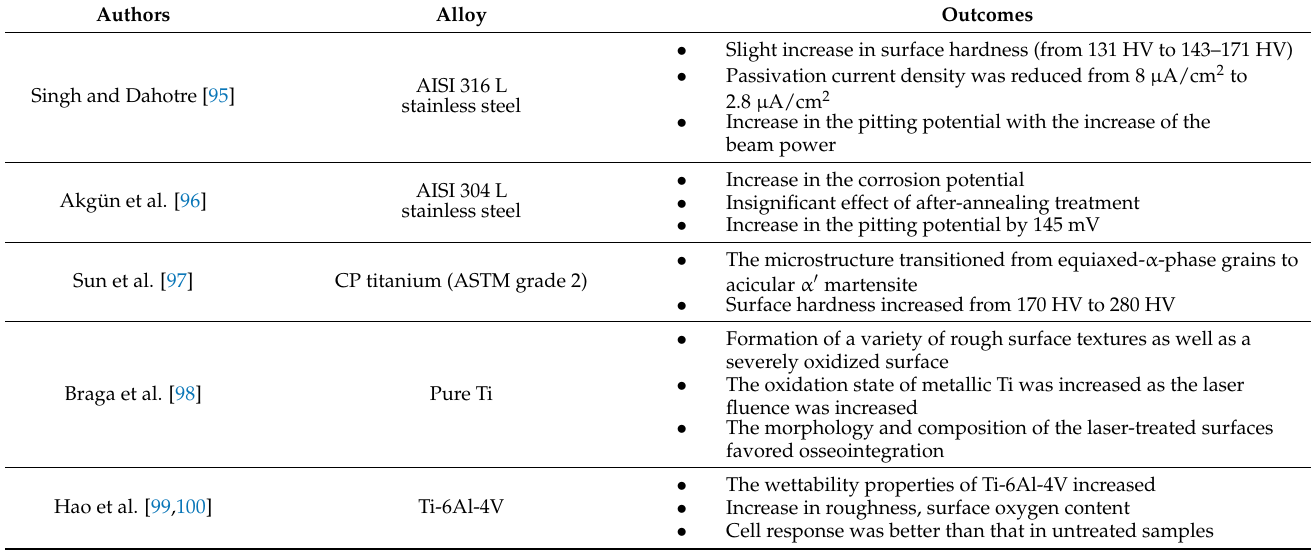
Table 6. LSM treatment on biomedical alloys.